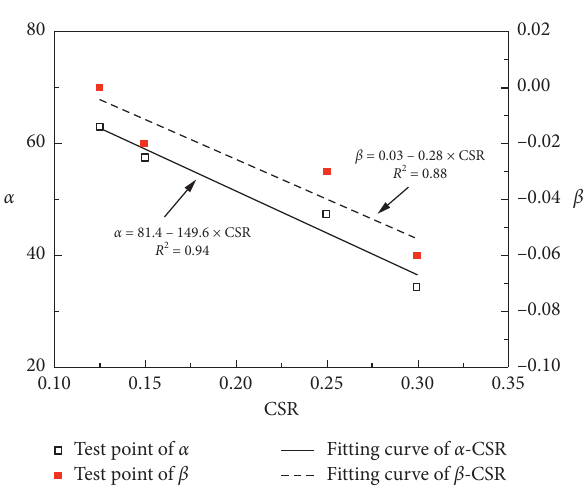
CSRFitting curve of α- CSR Fitting curve of β-